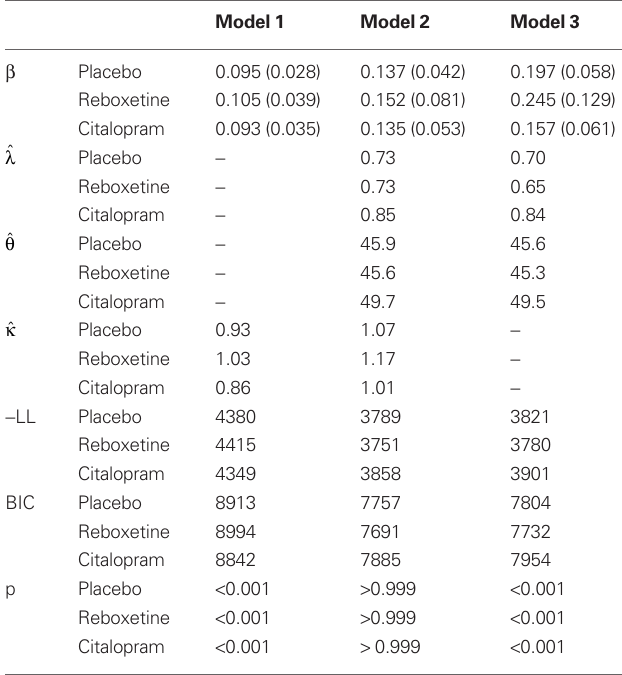
Table S1 | Mean parameter estimates and fit information for the three models, separately for each treatment group (SD in